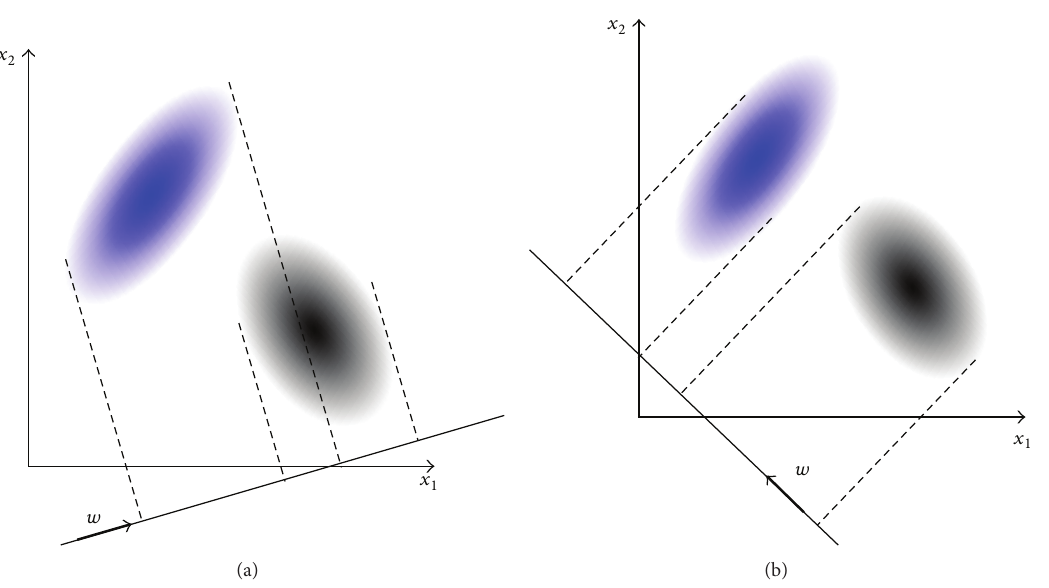
Figure 1: Projection of data x onto an axis in the direction of w